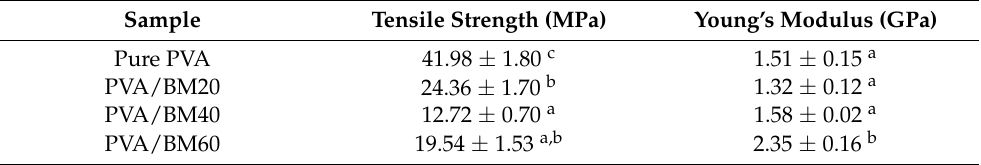
Table 1. The mechanical properties of pure PVA and PVA/BM composite films. Sample Tensile Strength (MPa)